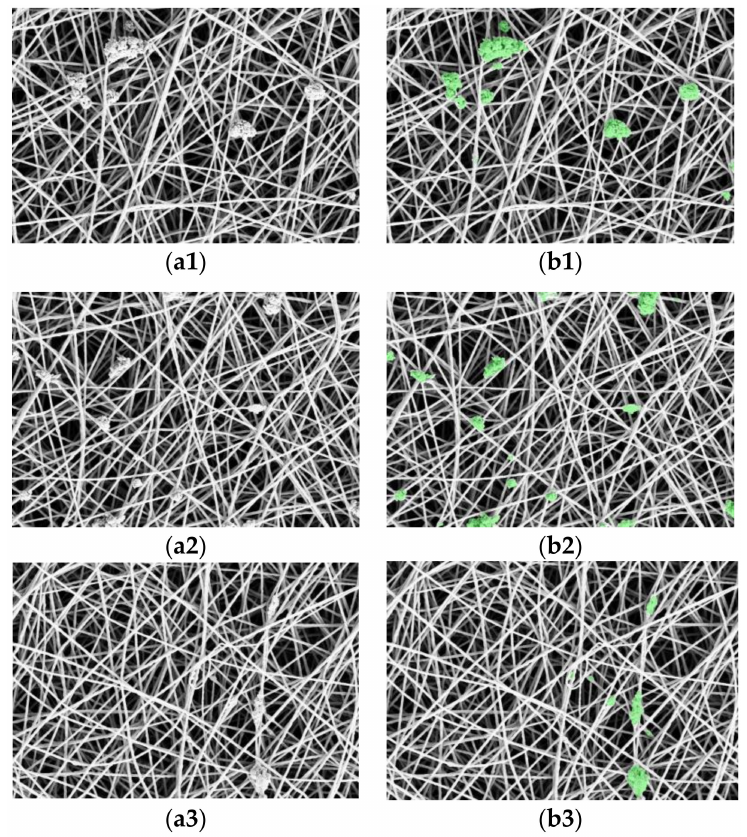
Figure 8. Examples of CASAE-processed images for different applications. The first columns are examples of ( a1 – a3 ) SEM images, and ( b1 – b3 ) result images of spot defects are marked in